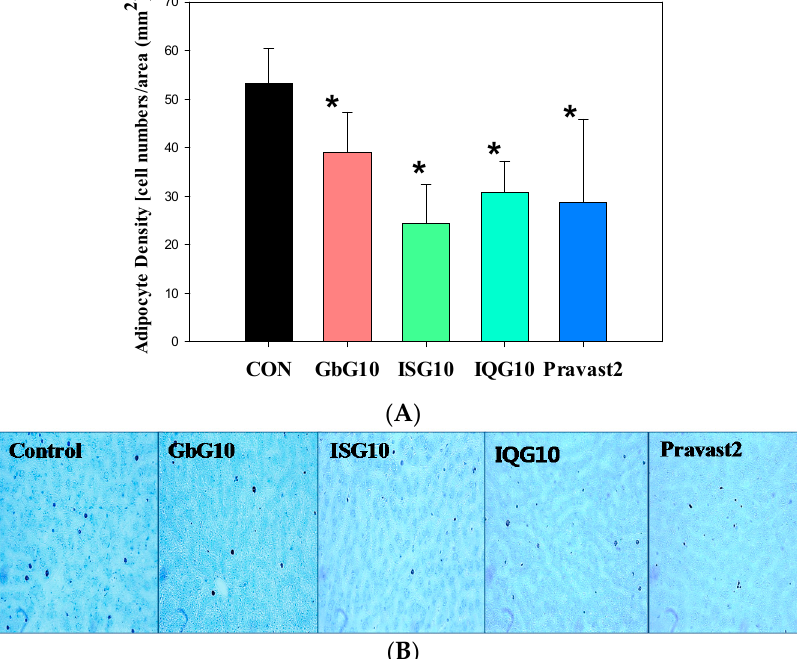
Figure 6. ( A ) Adipocyte number in rats treated with some GAG on HFD by toluidine blue O stain, ( n = 10 per group) (* p < 0.05): significant difference vs. HFD group. HFD, high fat diet. The adipocyte cell density was counted from liver tissue toluidine blue stained depots. ( B ) Effect of IQG on morphology in the livers of rats fed HFD with IQG for one month. Representative toluidine blue O staining (fat cell depots) of liver tissue is shown at 400× magnification. Table 3. Fatty acid composition of abdominal fat of high fat diet rats treated with insect glycosaminoglycan over a one month period.